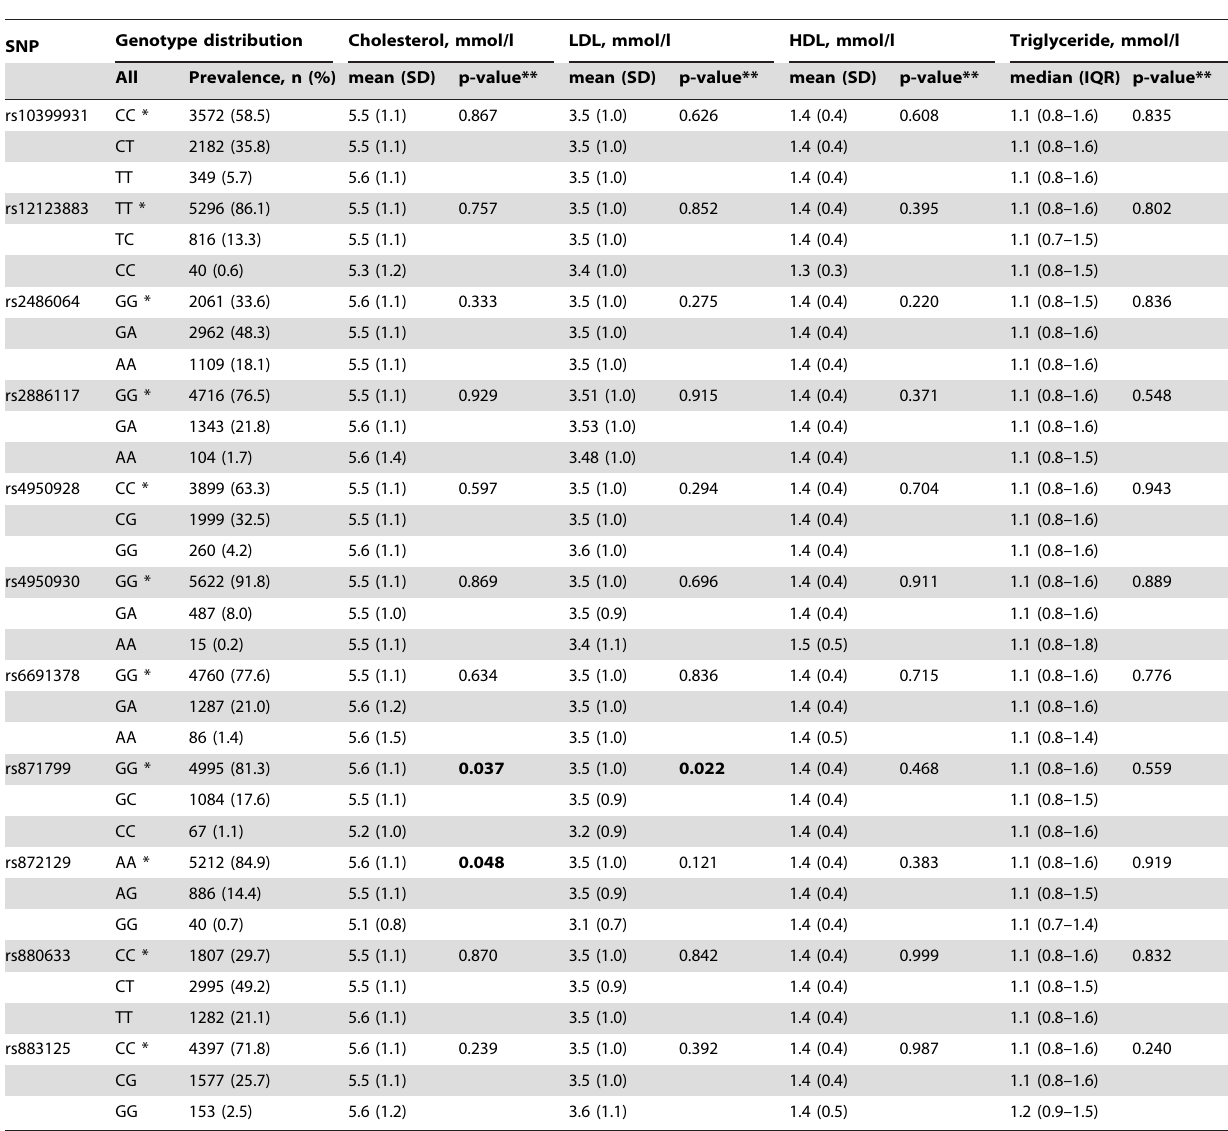
Table 4. The relationship between 11 single nucleotide polymorphisms (SNPs) of CHI3L1 and lipid levels in